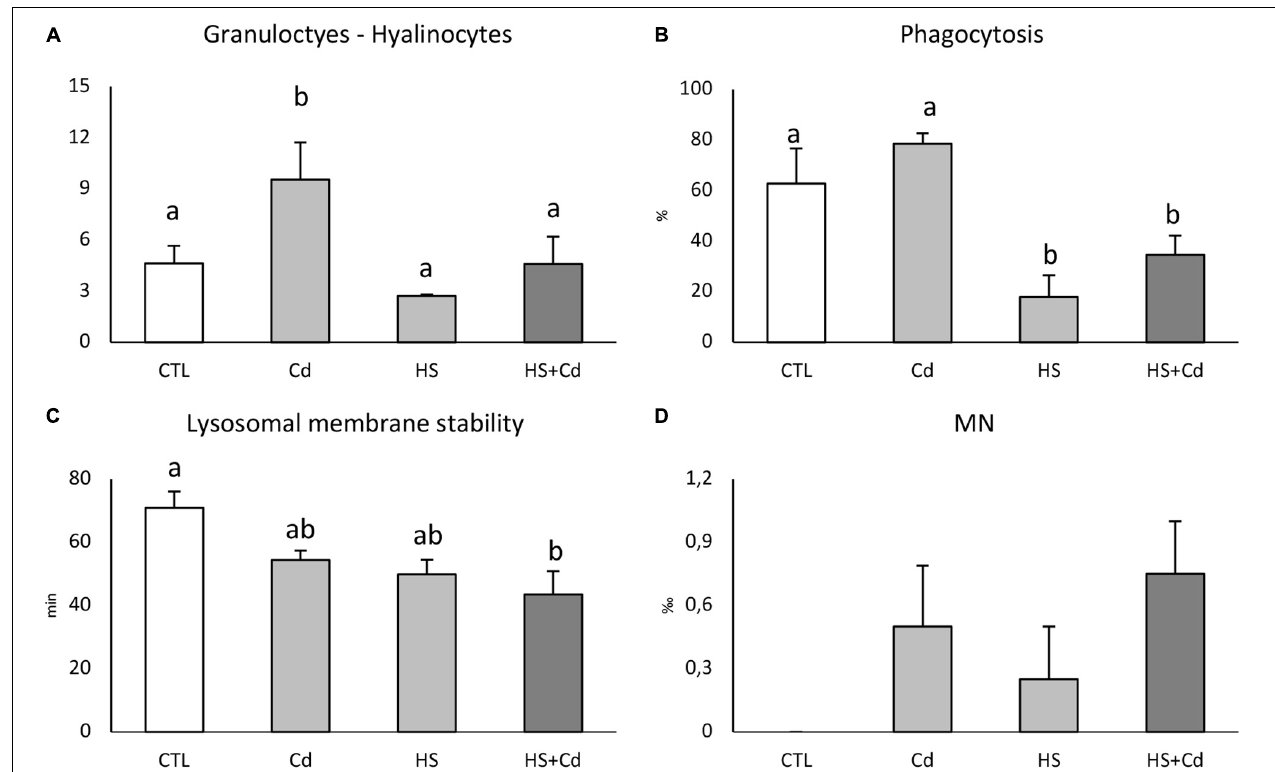
FIGURE 3 | Hemocytes functional analyses of exposed mussels. Granulocytes:hyalinocytes ratio (A) , phagocytosis rate (B) , lysosomal membrane stability (C) , and micronuclei frequency (D) . Values are given as mean ± standard deviation, n = 4. Letters are used to highlight significant differences between group of means, CTL, Control; Cd, Cadmium exposure; HS, heat stress; HS + Cd, Cadmium exposure under heat